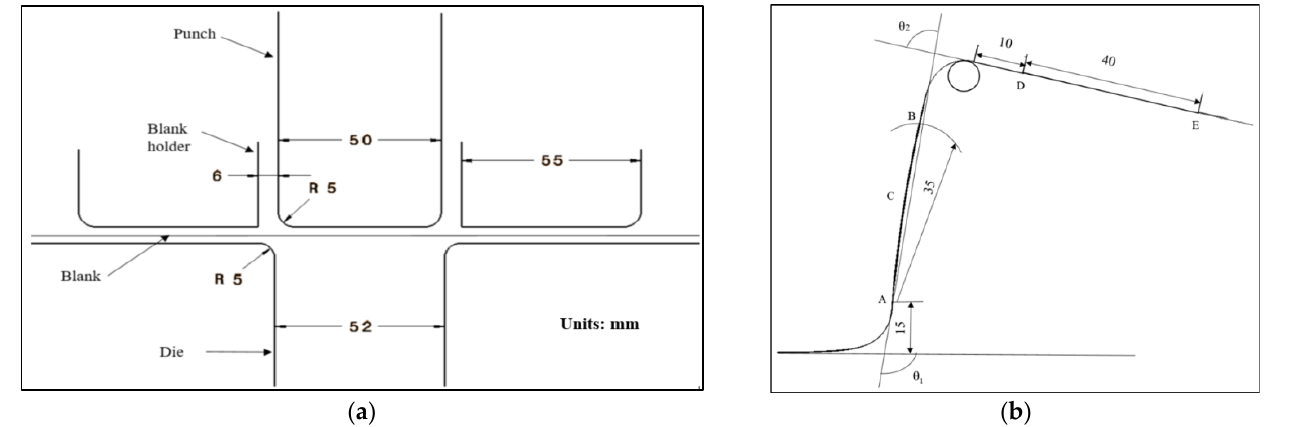
Figure 2. ( a ) Dimensions of the draw-bend setup for forming a U-channel according to Numish- eet ’ 93 ( b ) Springback measurements for a drawn U-channel according to Numisheet ’ 93. ( b ) Springback measurements for a drawn U-channel according to